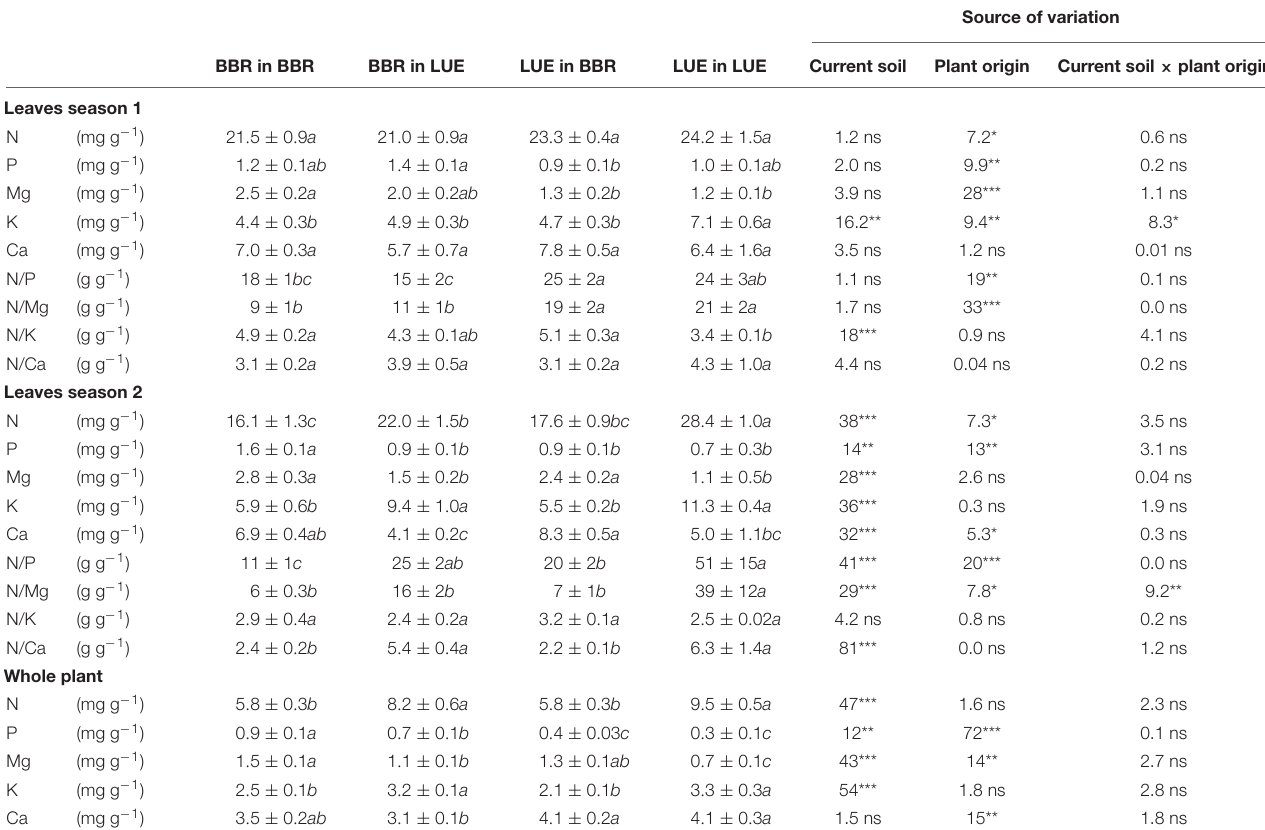
TABLE 2 | Nutrient concentrations and ratios in full season leaves, as well as average nutrient concentrations in the whole plant for beech ( Fagus sylvatica L.) saplings originating from the sites Bad Brückenau (BBR) and Unterlüss (LUE), respectively.